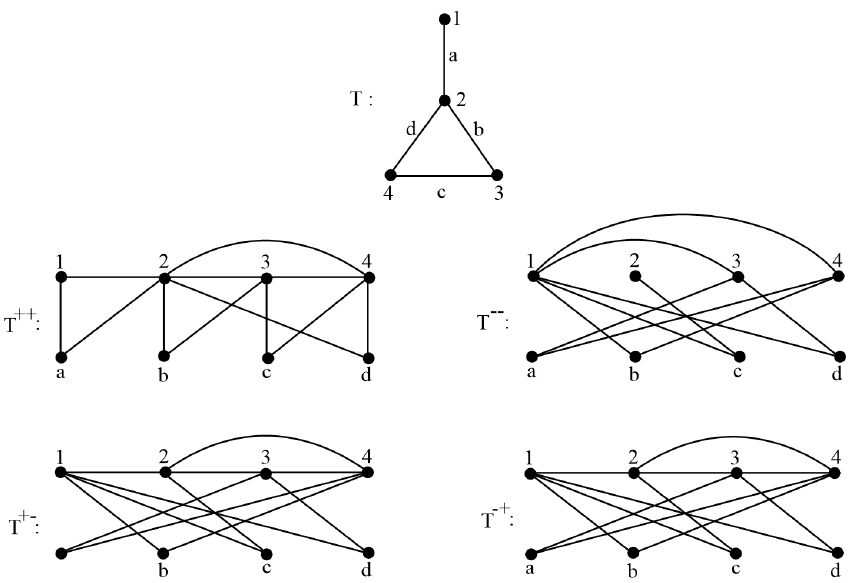
Figure 1. A graph T and its four transformation